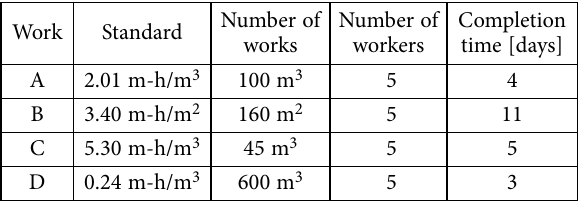
Figure 1. One-point network of relations used in the example Table 1. Data in the relationship network according to Figure 1